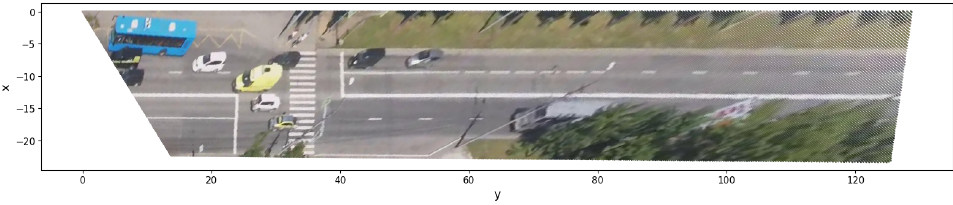
Figure 13. The Q π set visualization in plane Π for case